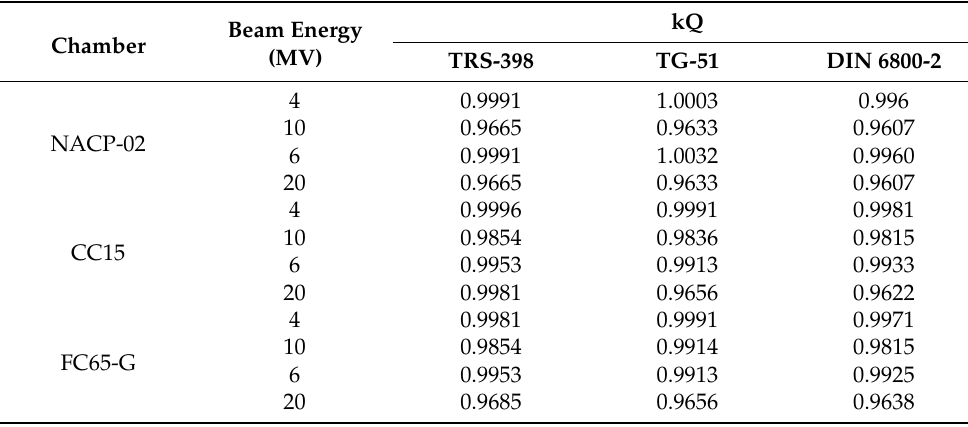
Table 3. k Q,Q0 values for the ion chambers used in this